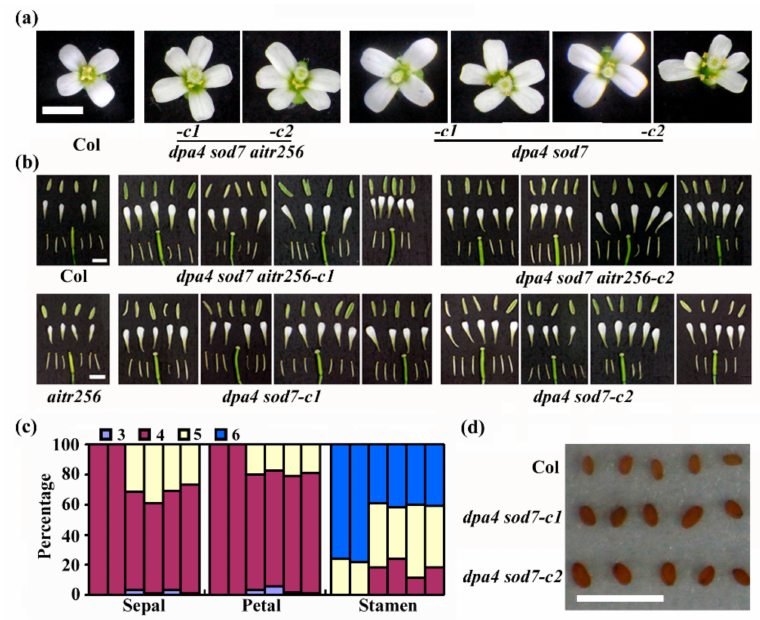
Figure 7. Flower morphology and seed size of the dpa4 sod7 aitr256 quintuple and the dpa4 sod7 double mutants. ( a ) Flowers of the Col wild type, the aitr256 triple, the dpa4 sod7 aitr256 quintuple and dpa4 sod7 double mutants. Pictures were taken from flowers on the main inflorescence stems of the plants indicated. ( b ) Floral organs of the Col wild type, the aitr256 triple, the dpa4 sod7 aitr256 quintuple and dpa4 sod7 double mutants, showing irregular number of sepals, petals and / or stamens. ( c ) Percentage of floral organs of the Col wild type, the aitr256 triple, the dpa4 sod7 aitr256 quintuple and dpa4 sod7 double mutants. From left to right, Col, aitr256, dpa4 sod7 aitr256-c1 , dpa4 sod7 aitr256-c2 , dpa4 sod7-c1 and dpa4 sod7-c2 . A total of 100 flowers for each genotype from the main inflorescence stems of the plants indicated were investigated. ( d ) Seeds of the Col wild type and the dpa4 sod7 double mutants. Picture of dry seeds was taken for the plants indicated. Bar, 0.2